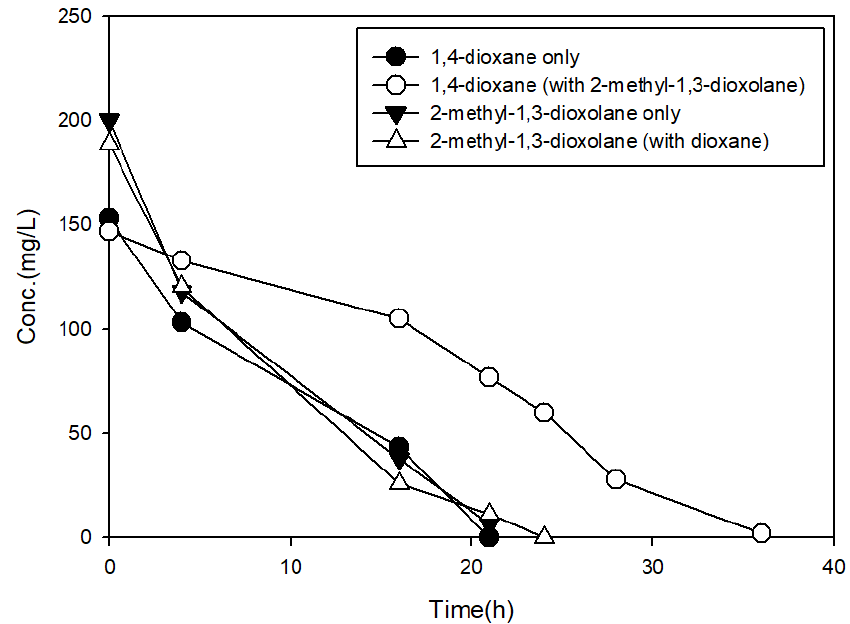
Figure 11. Biodegradation of 1,4-dioxane in the presence of